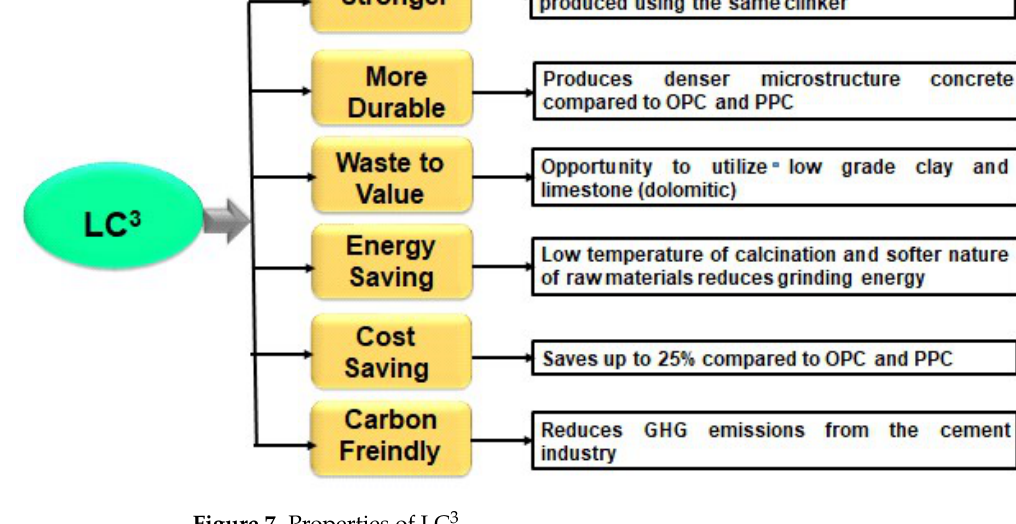
Figure 7. Properties of LC 3 .